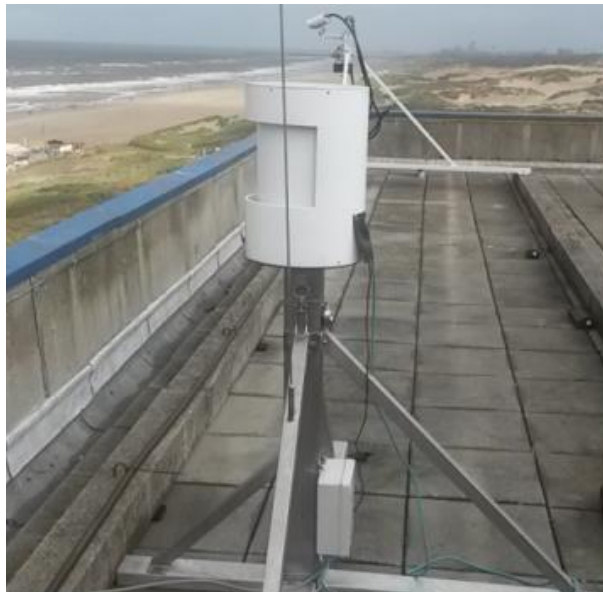
Figure 2. Riegl VZ2000 laser scanner mounted on the roof of a hotel facing the coast of Kijkduin, the Netherlands. The scanner is covered with a protective case to shield it from wind and rain.